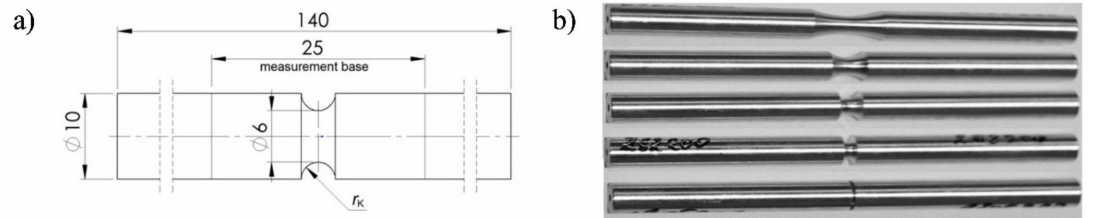
Figure 6. ( a ) Dimensions of specimens used for testing (unit: mm), ( b ) real specimens used in